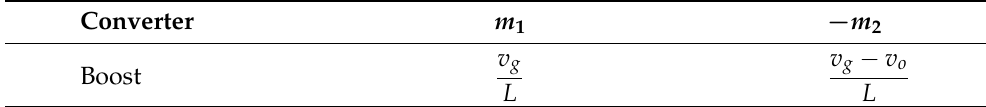
Table 2. Slope of the inductor current